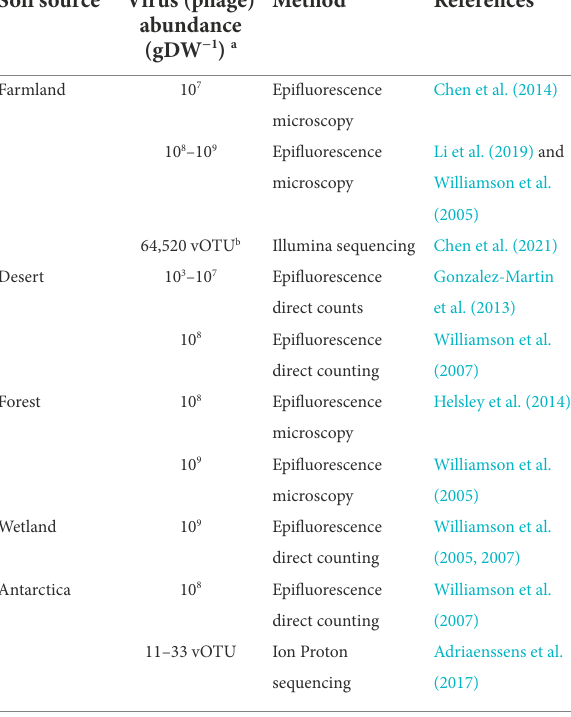
TABLE 1 The viral abundance in different soil